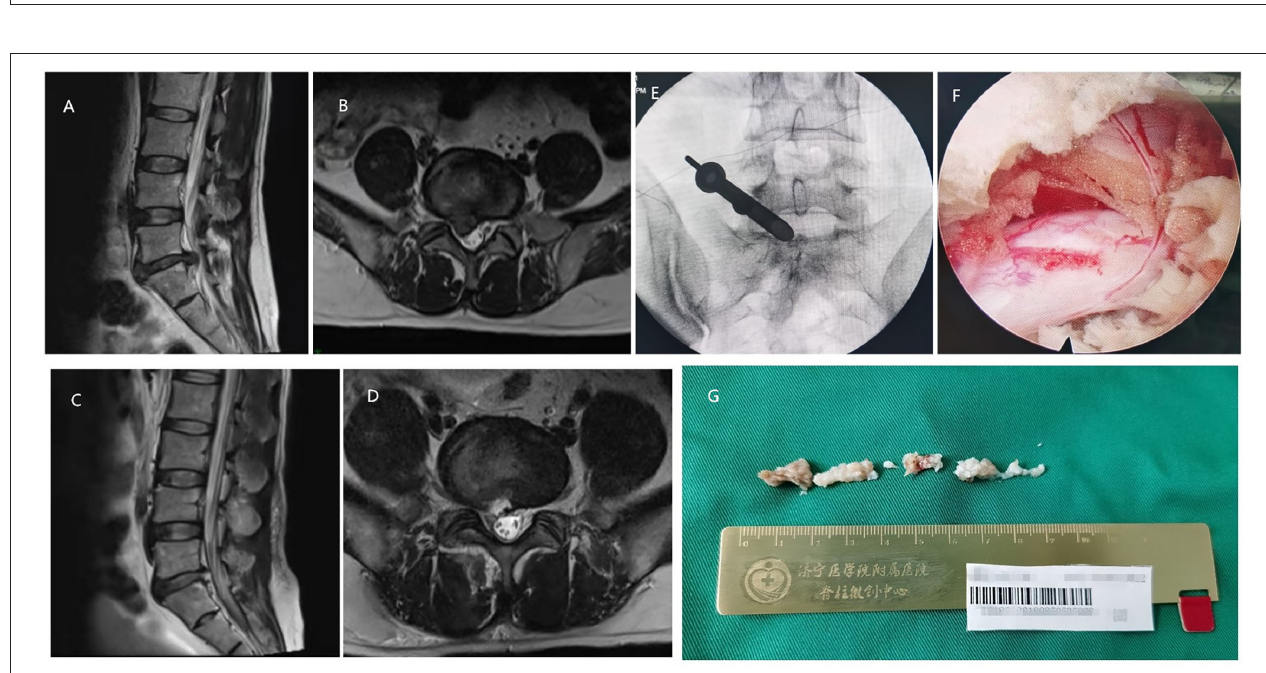
FIGURE 2 | A 56-year-old male with the L5/S1 LDH underwent PELD with the approach of interlaminar. (A,B) Preoperative MRI showed LDH was located at the L5/S1 level. (C,D) Postoperative MRI revealed the herniated nucleus pulposus tissues were removed and the nerve root was decompressed. (E) Intraoperative C-arm fluoroscopy showed the location of the working channel. (F) The decompressed nerve root under endoscopic view. (G) Resected nucleus pulposus tissues in the operation.